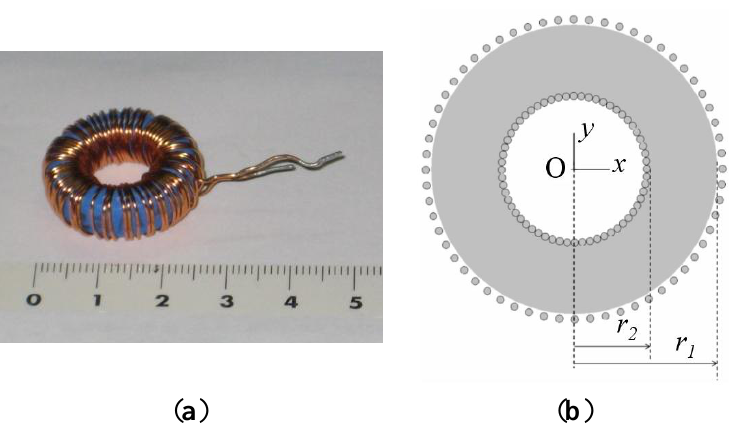
Figure 1. ( a ) Real inductor; ( b ) 2D